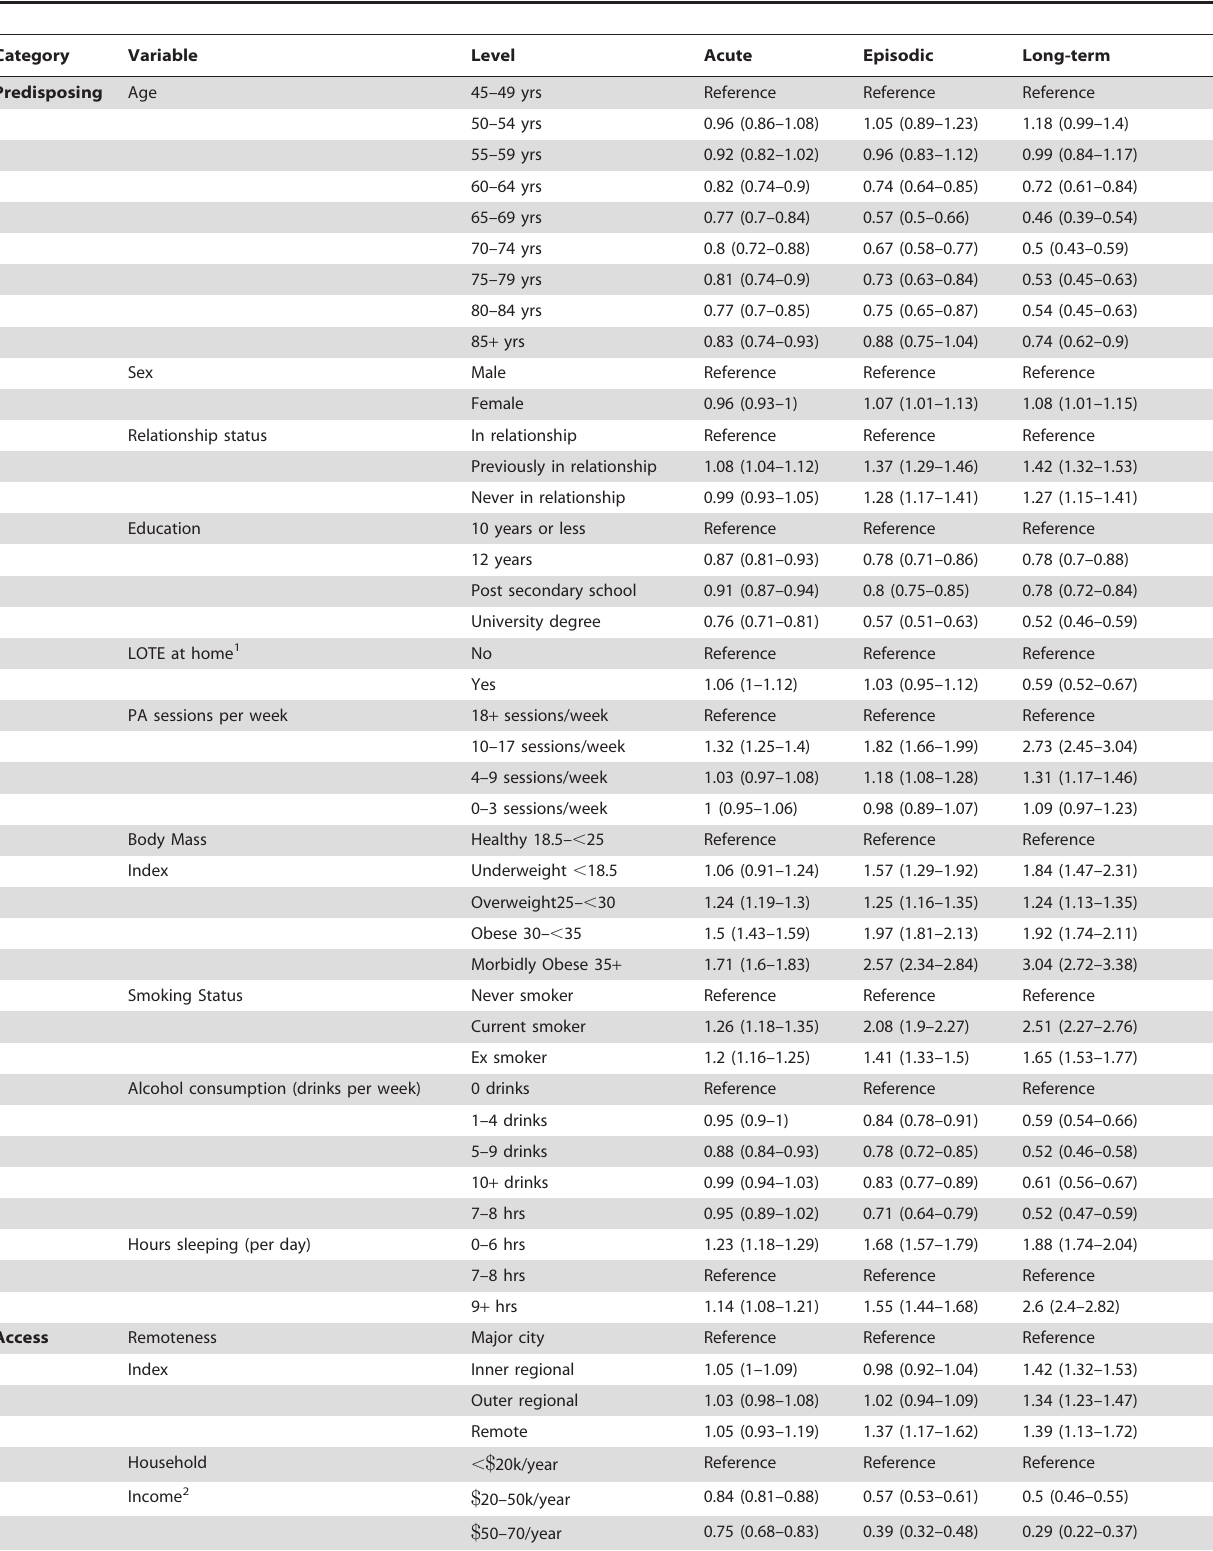
Table 4. Rate-ratio (RR) of the association of variables (by Andersen-Newman model categories of Predisposing, Access, and Need) belonging to an opioid analgesic treatment group (Acute, Episodic, Long-term – see Methods and Materials for details) with those not dispensed an opioid analgesic as the reference group, each variable adjusted for age and